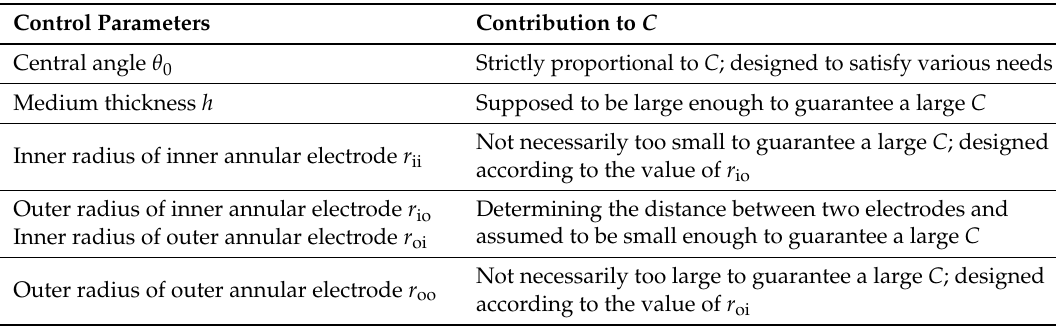
Table 1. Contributions of different control parameters to capacitance value C .